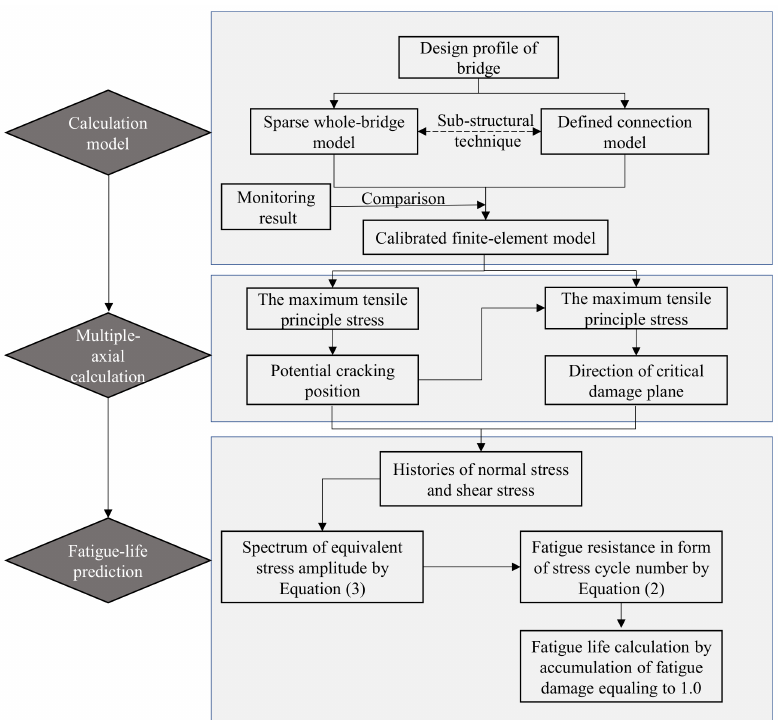
Figure 1. Fatigue-life evaluation and assessment